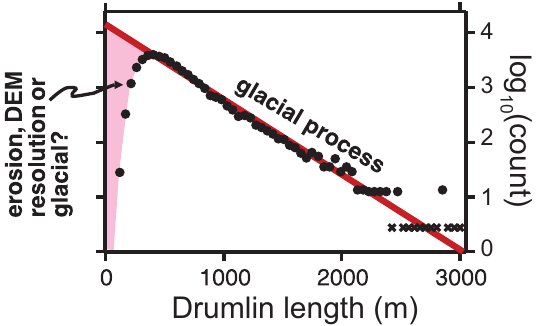
Figure 2. Semi-logarithmic frequency plot of the lengths, L , of UK drumlins adapted from Hillier et al. (2013). Black dots are data digitised from Fig. 8 of Clark et al. (2009), with a bin width of ∼ 50m. Red line is the exponential trend. Crosses indicate zero counts, placed at a nominal value of 1. Aspects of the curve are speculatively associated with processes, i.e. glacial, or related to erosion and DEM